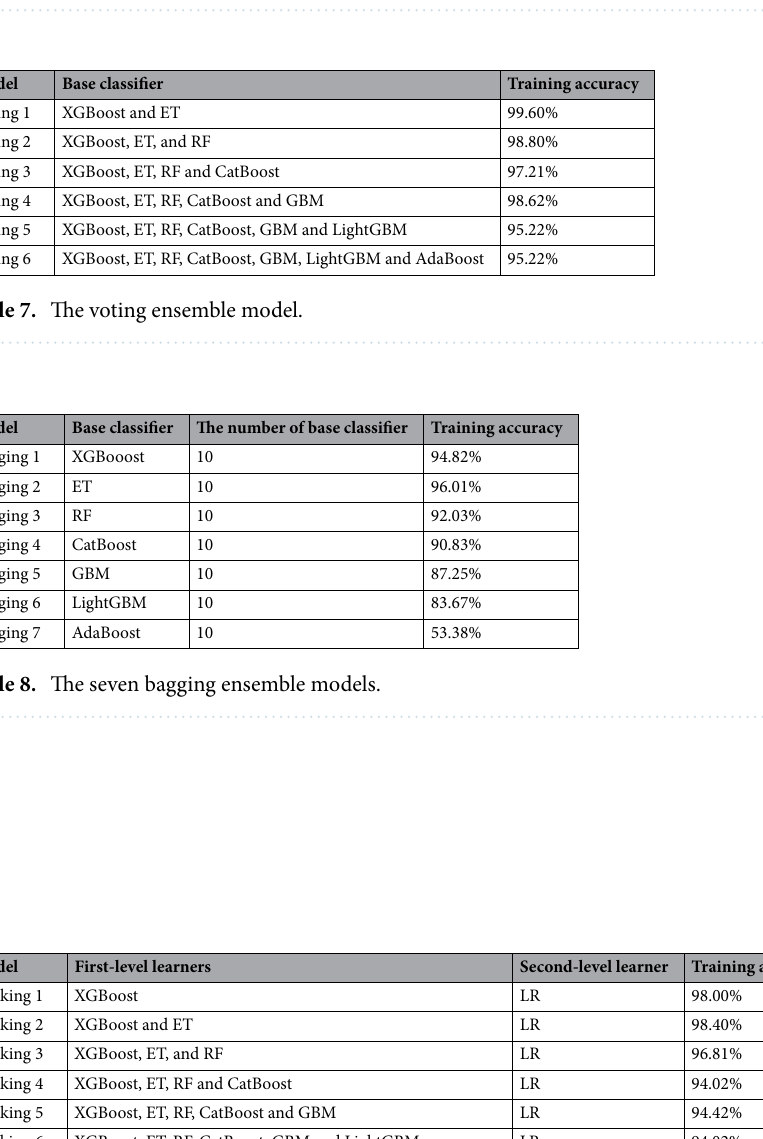
Figure 8. The training accuracy variation of seven models.